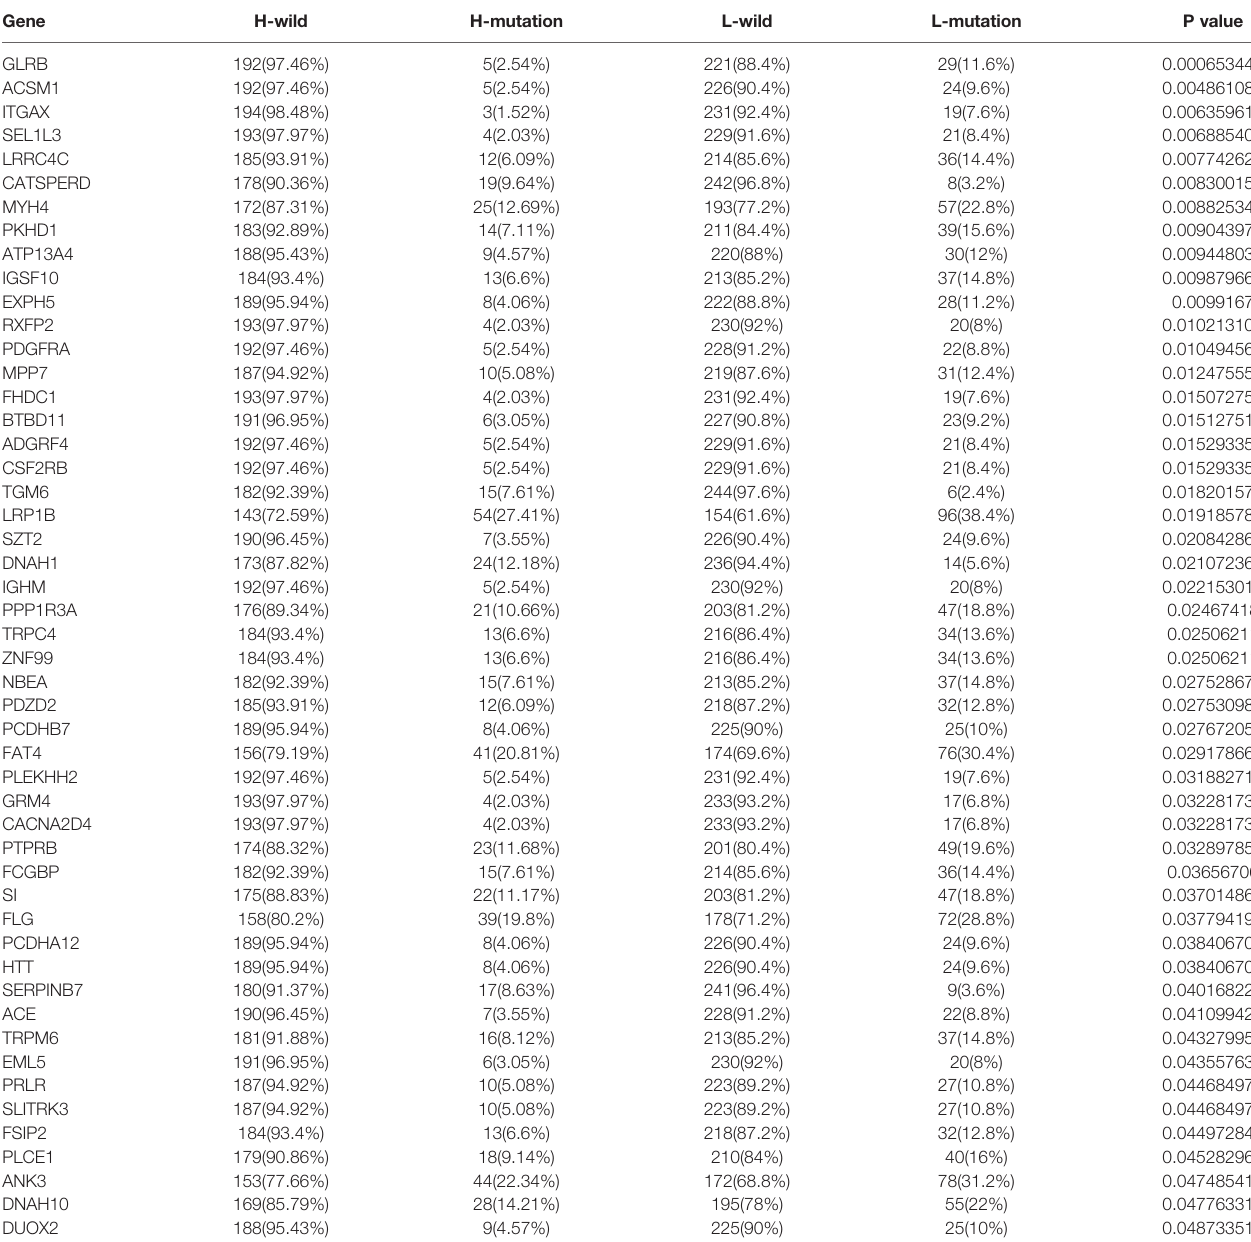
TABLE 1 | The Correlation between the ICI Scores and Somatic